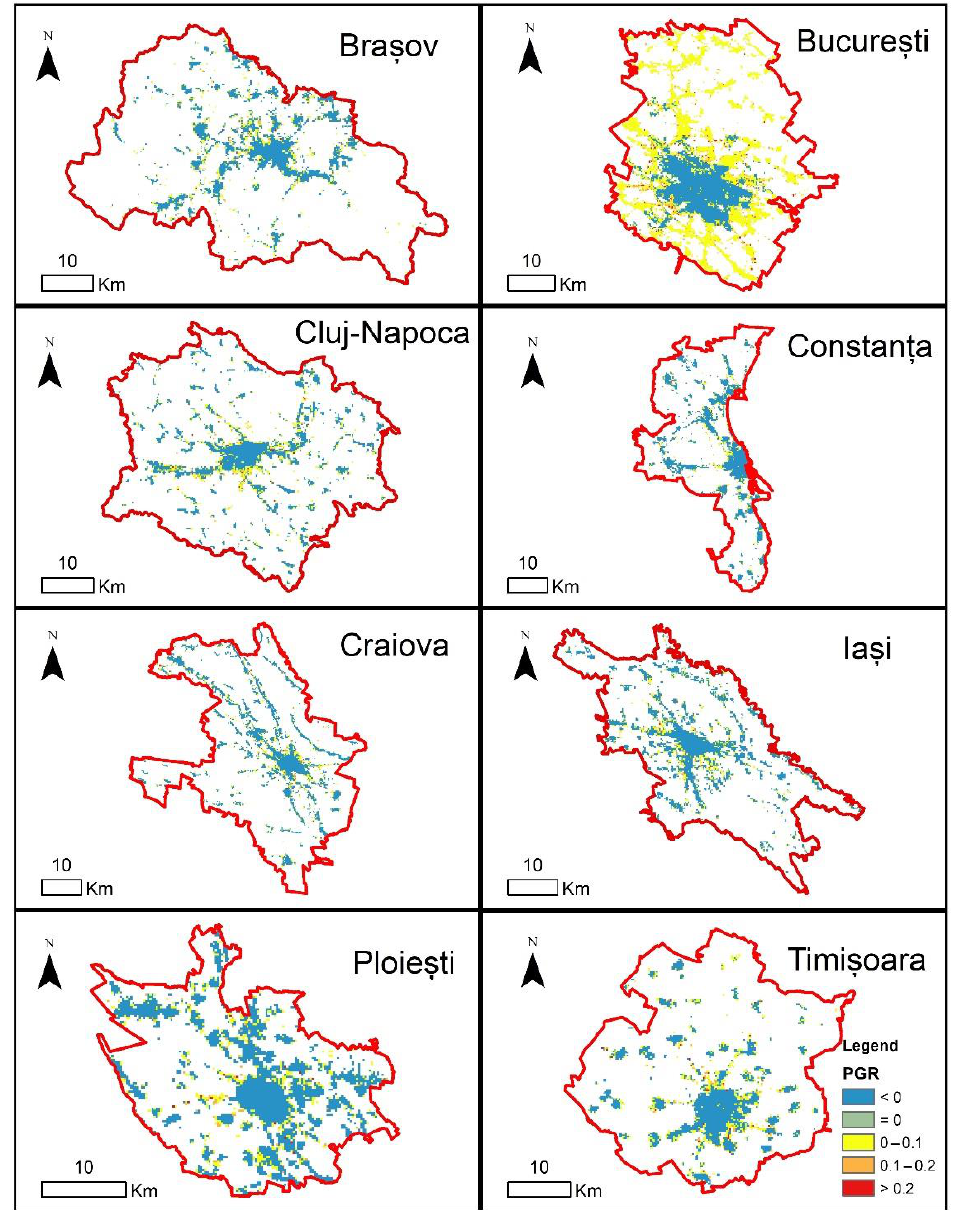
Figure 4. Distribution of the PGR values at grid level for 2000 – 2014.